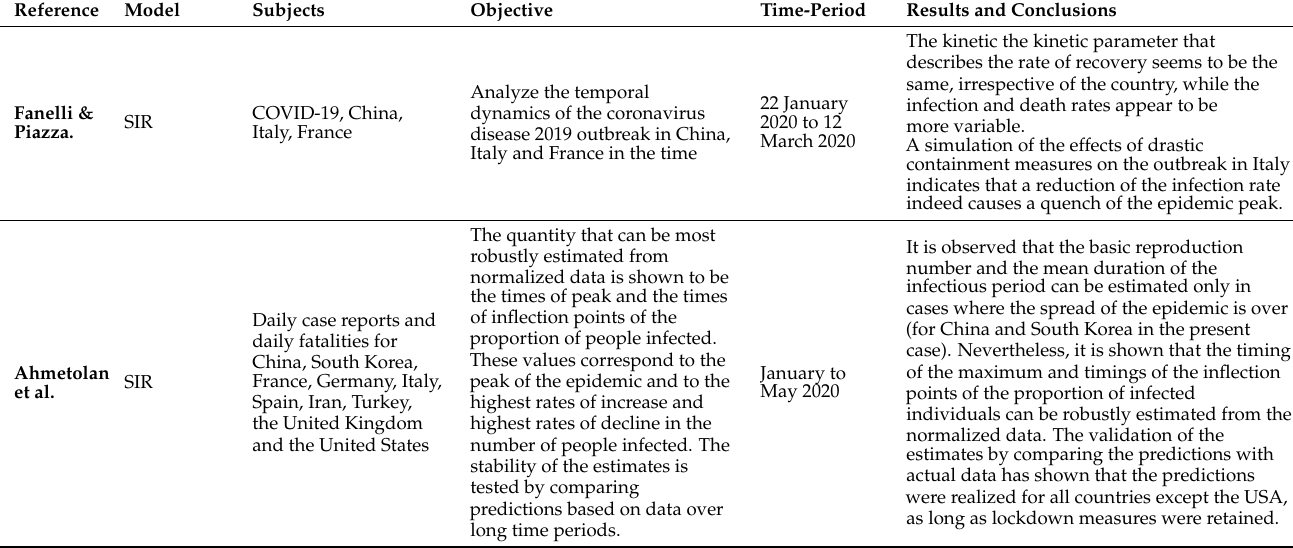
Figure 2. Parameters included in some of the main standard epidemiological models applied in COVID-19 prediction studies [18-25]. Table 1. Main objectives and conclusions of relevant epidemiological models applied during the COVID-19